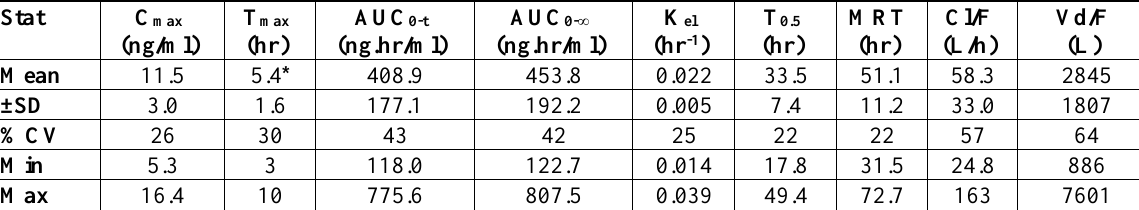
Table1. Pharmacokinetic parameters of fluoxetine 20 mg capsules under fasting and fed conditions